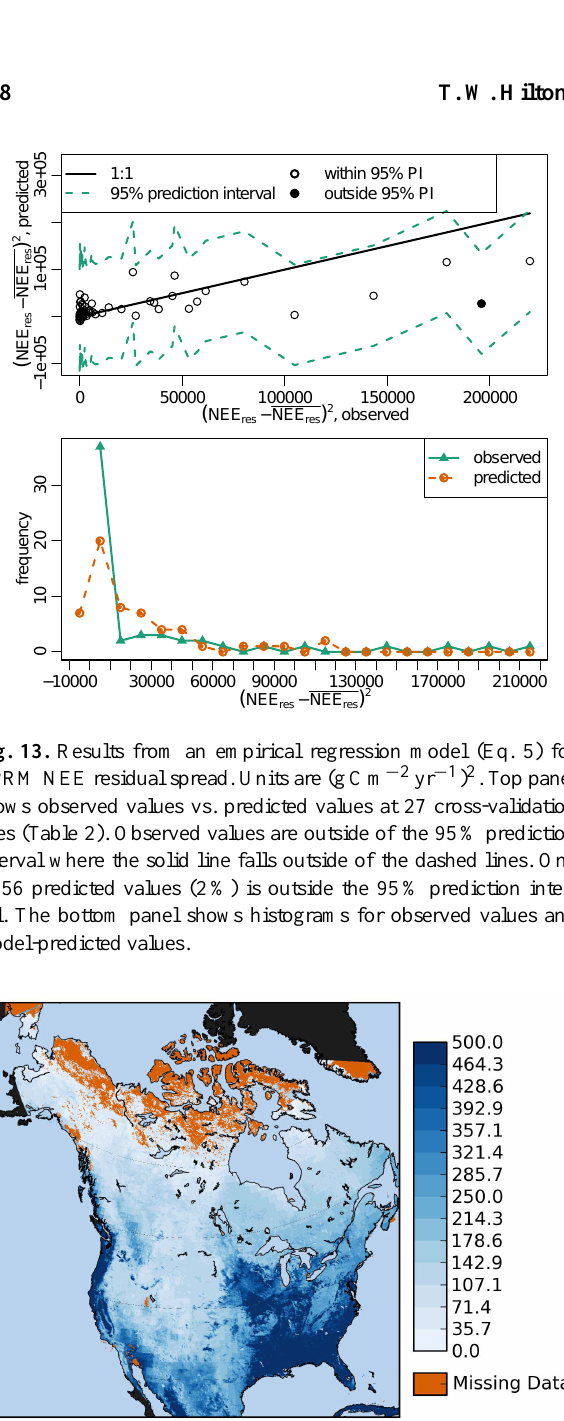
Fig. 14. The 2002 estimated square root of NEE residual squared difference (Eq. 4), calculated using PFT–all-data VPRM parame- ters. Units are gCm − 2 yr − 1 . Estimates are calculated by a statis- tical model (Eq. 5, Sect. 2.5) with explanatory variables annual in- tegrated VPRM NEE, annual total precipitation, and annual mean surface temperature. The 2003–2006 estimated annual errors (not shown) show similar spatial patterns.